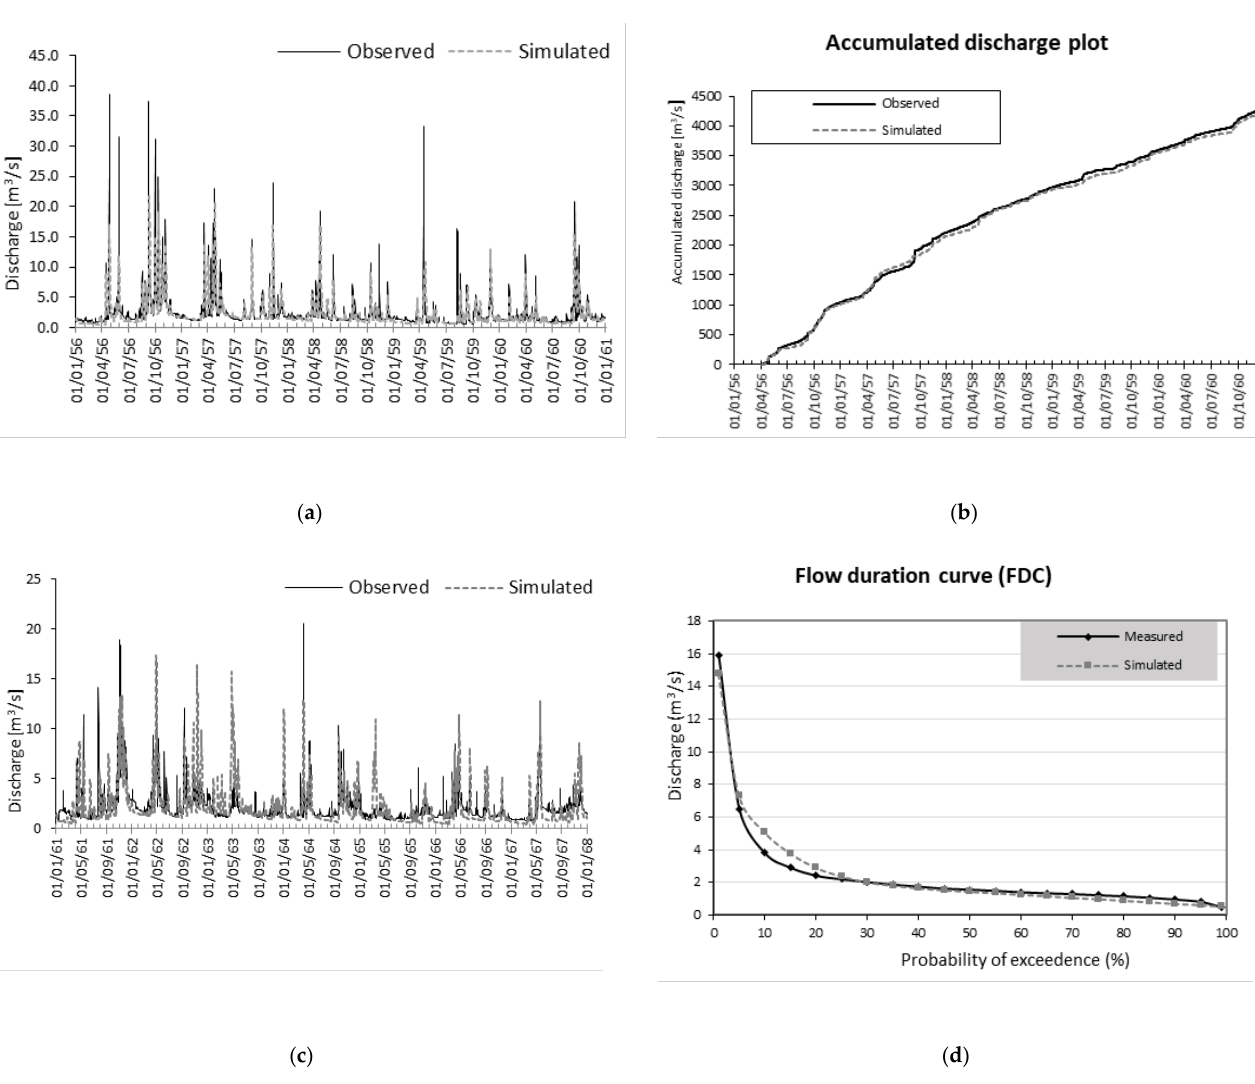
Figure 3 . Sebwe calibration plot ( a ), accumulated discharge plot ( b ), Validation plot ( c ) and Flow Duration Curve ( d ) .